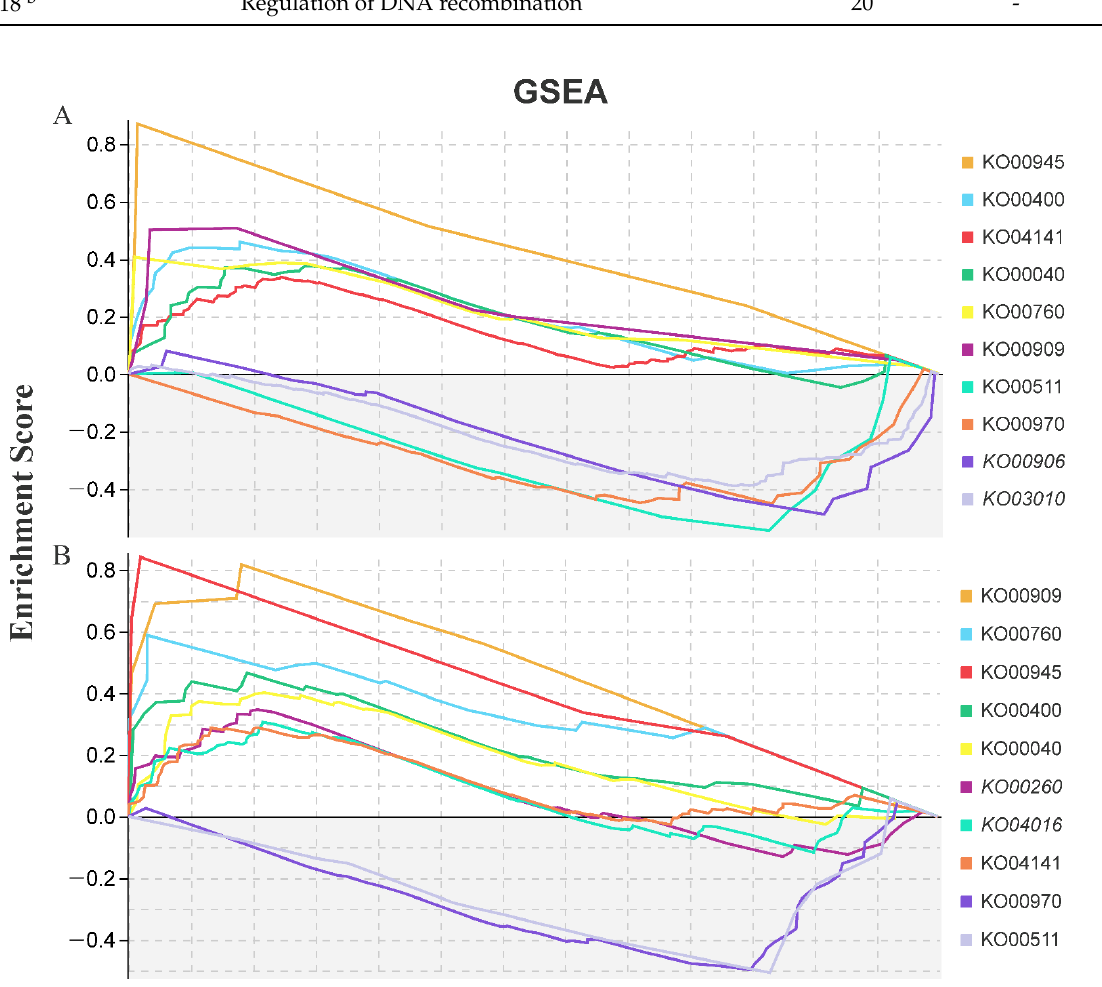
Figure 4. Enriched KEGG terms according to gene set enrichment analysis (GSEA) tools in M. cerifera after LAS and HAS treatments (A, LAS; B, HAS). The gene sets with a normal p value of <0.05 and FDR rate of <0.25 were considered significantly enriched.